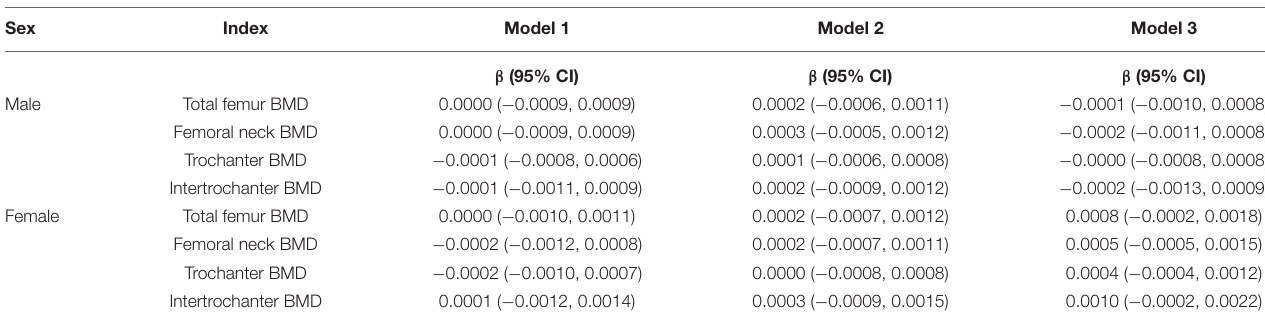
TABLE 4 | Association between dietary fiber intake and femoral BMD stratified by